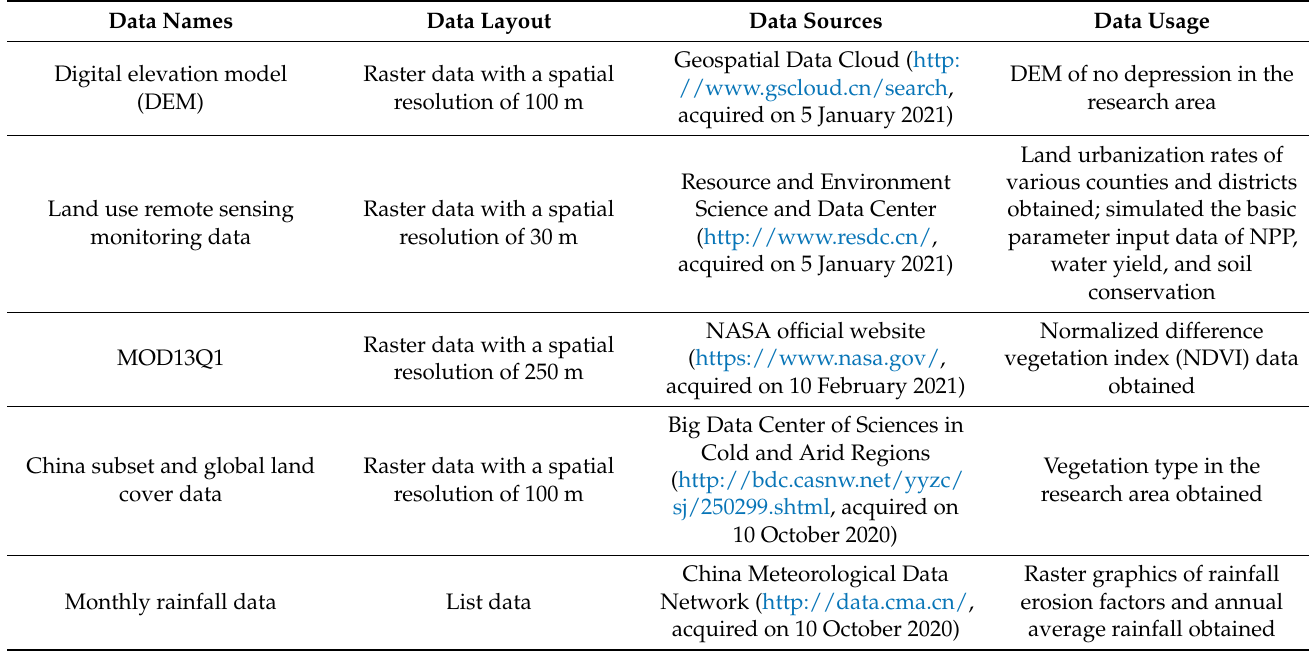
Table 1. Data source and usage.